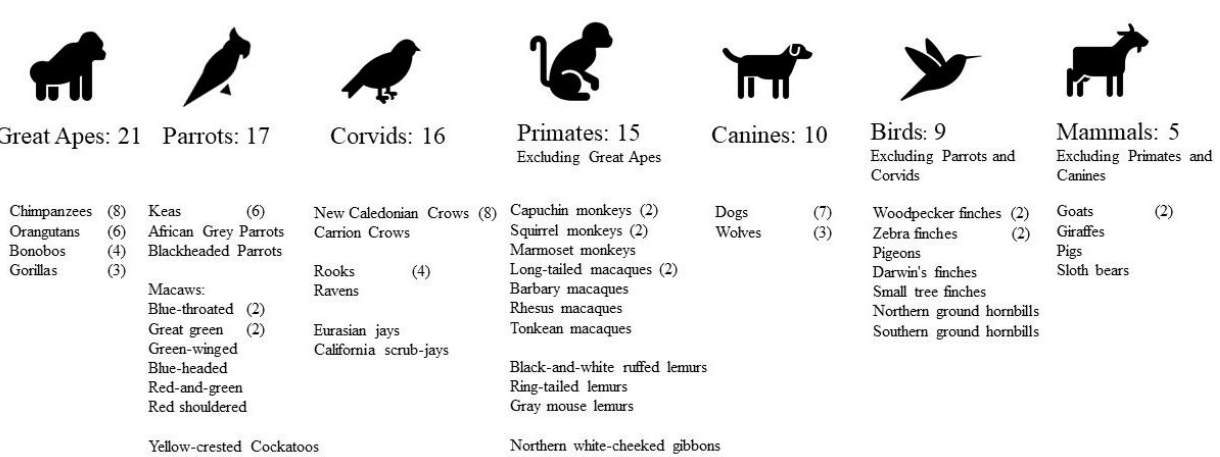
The Number of Papers Investigating Each Species or Family in Our Sample of Physical Cognition Papers